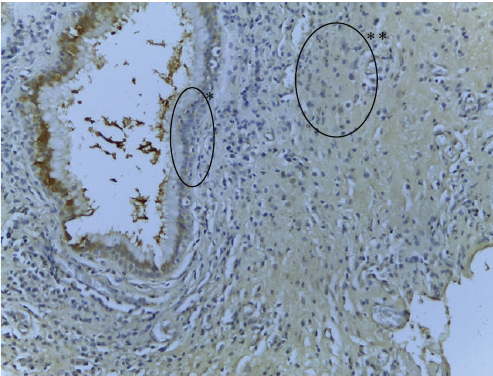
Figure 1: Nasal mucosa: PLUNC positive (+) IHC 40x. Very weak positivity for PLUNC antibodies in epithelium ( ∗ ) and small lymphocytes ( ∗∗